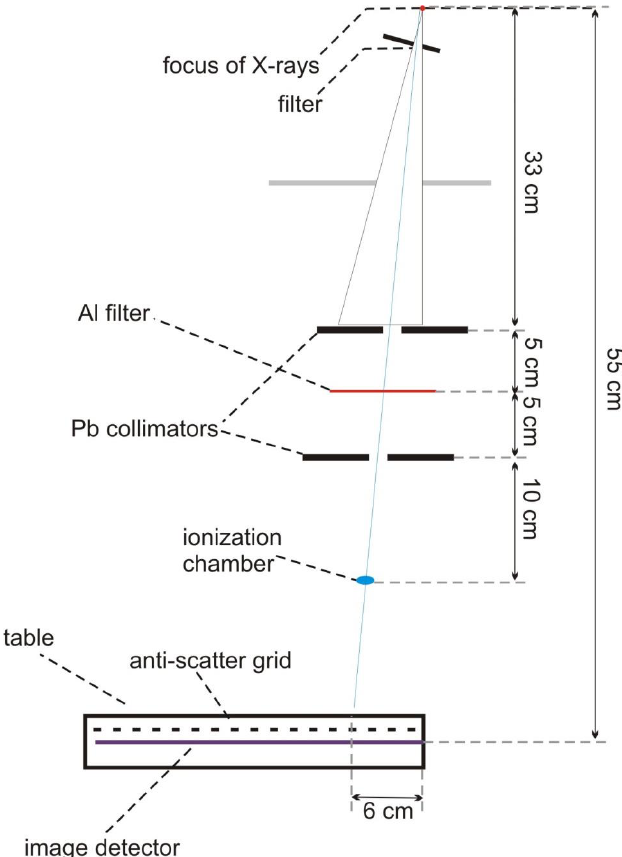
Figure 5. Scheme of the system for the HVL measurement. An analogous system was simulated to verify the simulation through comparison of the HVL values measured and those determined in simulations.